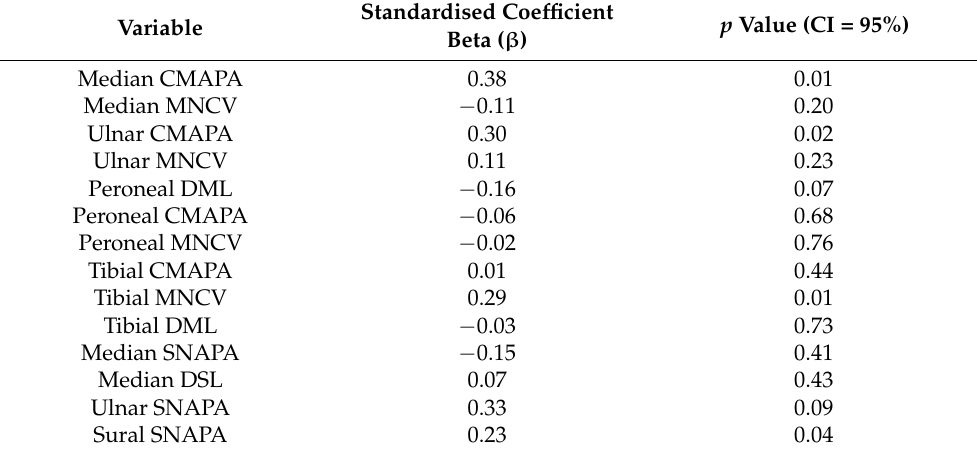
Table 6. Multivariate analysis between HRV Valsalva and independent variables.